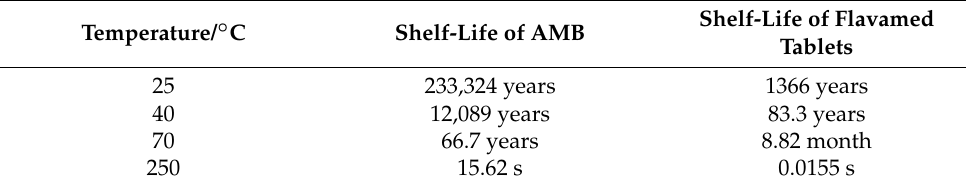
Table 4. The shelf-life for pure AMB and in Flavamed ® formulation. Temperature/ ◦ C Shelf-Life of AMB